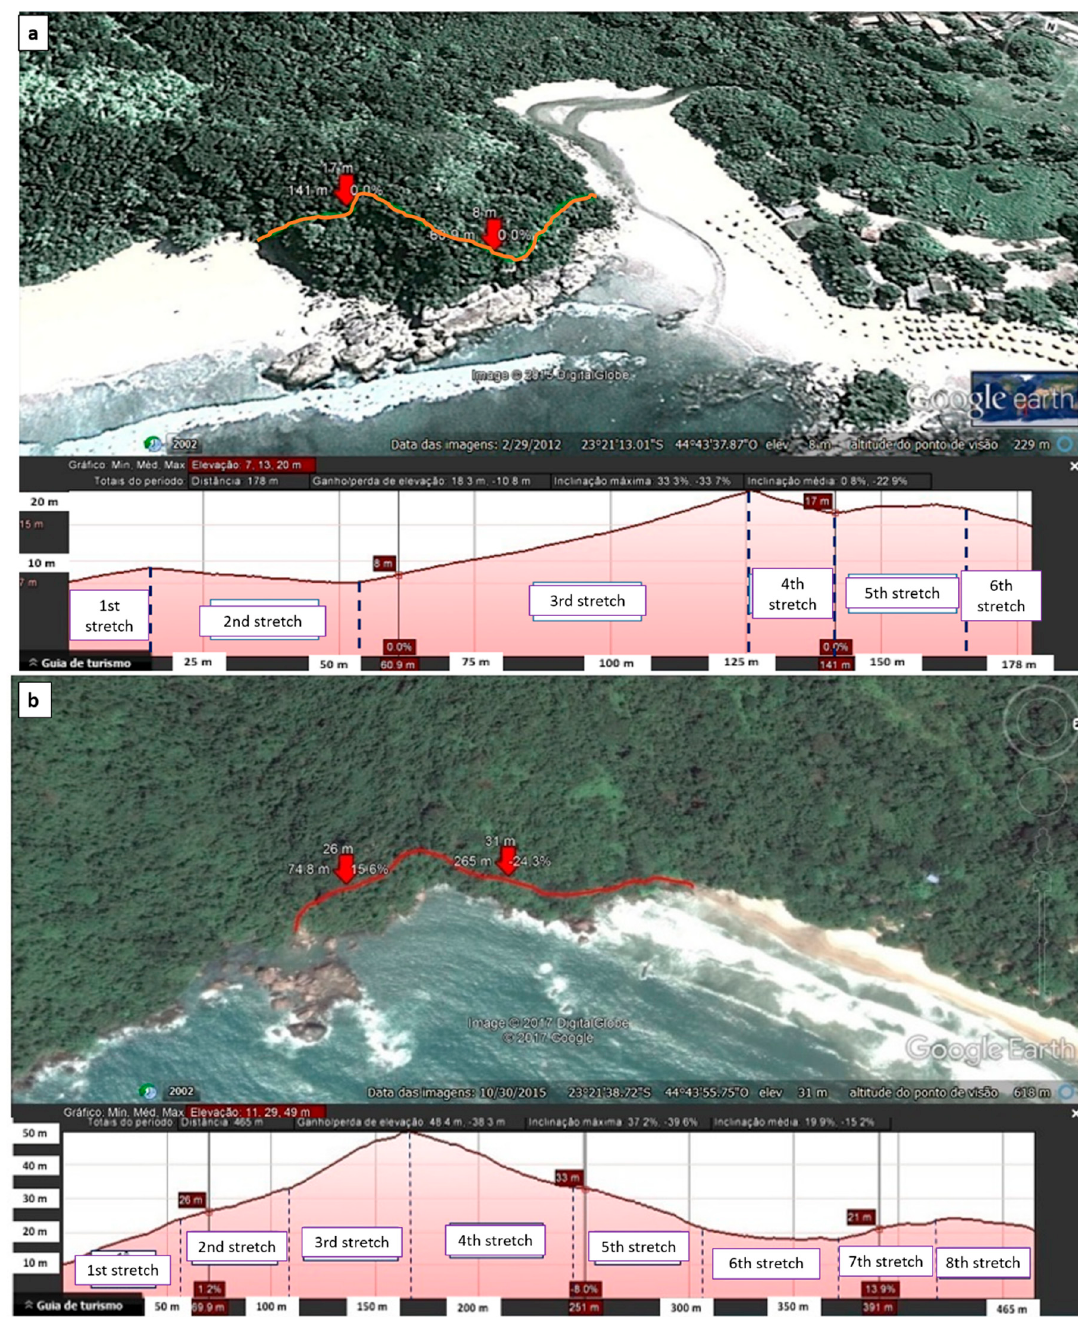
Figure 2. Elevation profile, location of ‘erosion bridges’ and division of MCB ( a ) and CNP ( b ) trails into sections based on topography. Adapted by L. Rangel from Google Earth. Image Source: Digital Globe.